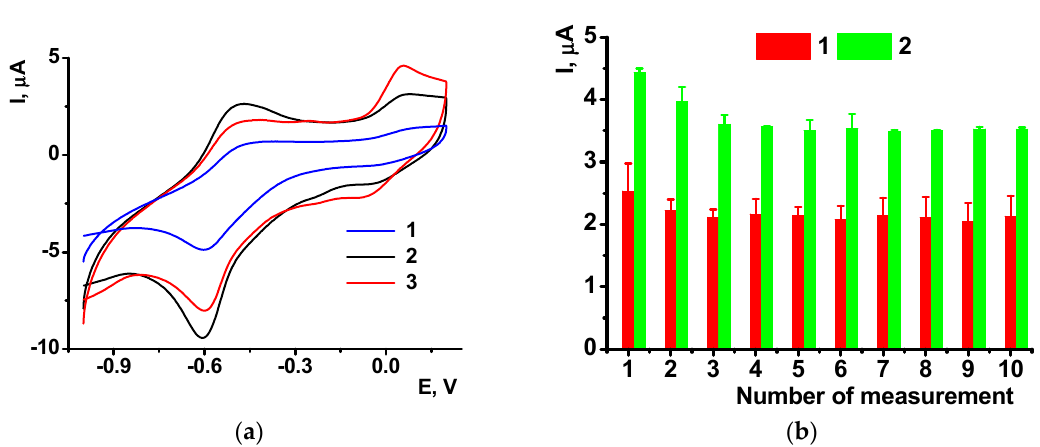
Figure 10. The poly-NR peaks recorded on glassy carbon electrode covered with CB/P[5]A in the absence of the monomer dye, the NR polymerization was performed in the presence of native (1), oxidized (2) DNA and that oxidized in the presence of 1.0 mM ascorbic acid (3) ( a ). Changes in the oxidation peak currents recorded in the presence of native (1) and oxidized (2) DNA in the series of consecutive measurements performed in 0.025 M phosphate buffer, pH 7.0 ( b ). Scan rate: 50 mV/s. Results are mean ± SD from six replications.